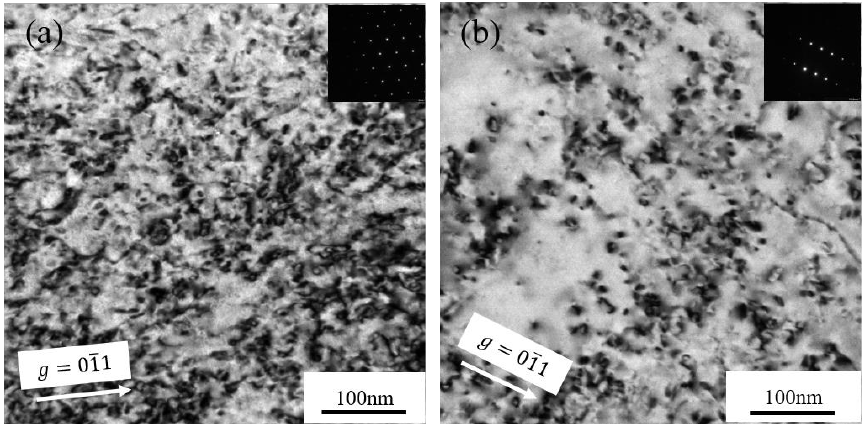
Figure 2. TEM bright-field micrographs of the Fe-Cr alloys before irradiation: ( a ) Fe-9Cr; ( b ) Fe- 9Cr-C.